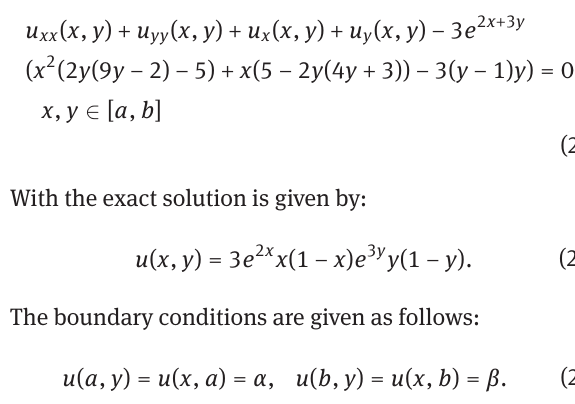
Figure 2: The numerical solutions with the exact solutions at x = 0.5 .